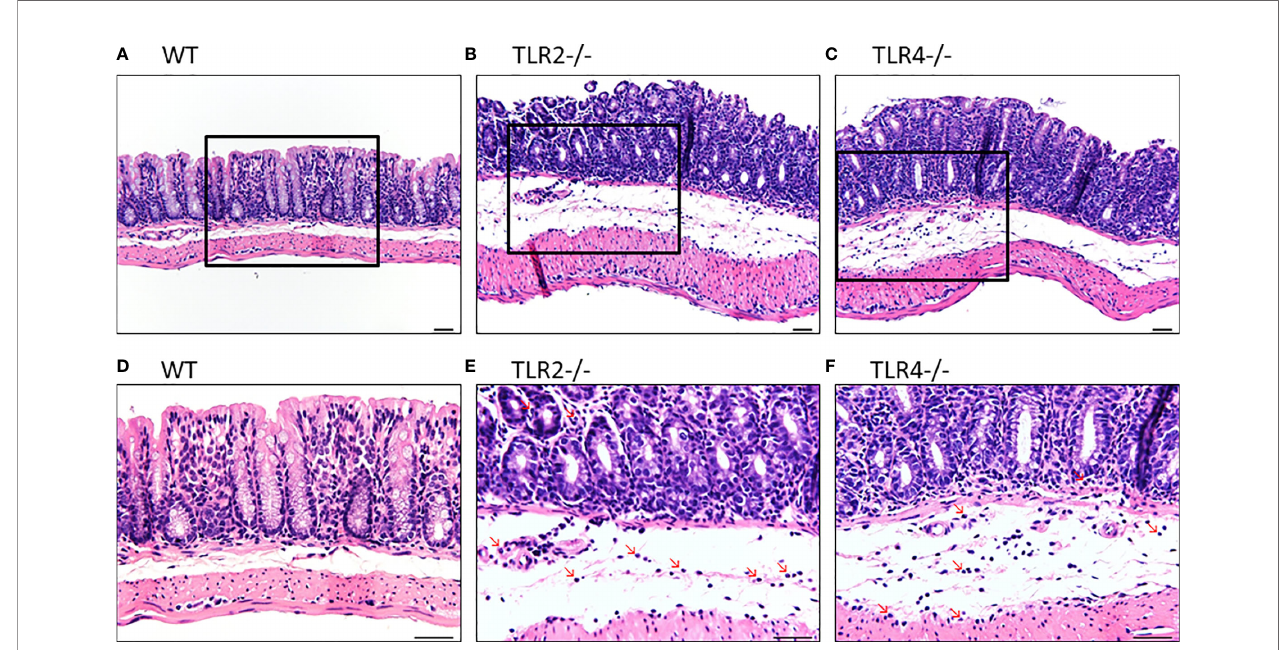
FIGURE 3 | Hematoxylin and eosin staining of colon tissues of mice of different genotypic backgrounds with CDI. Increased in fi ltration of in fl ammatory cells, especially neutrophils, in the colonic epithelium was noted in Tlr2-/- (B, E) and Tlr4-/- (C, F) mice compared with wild-type (WT: A, D )